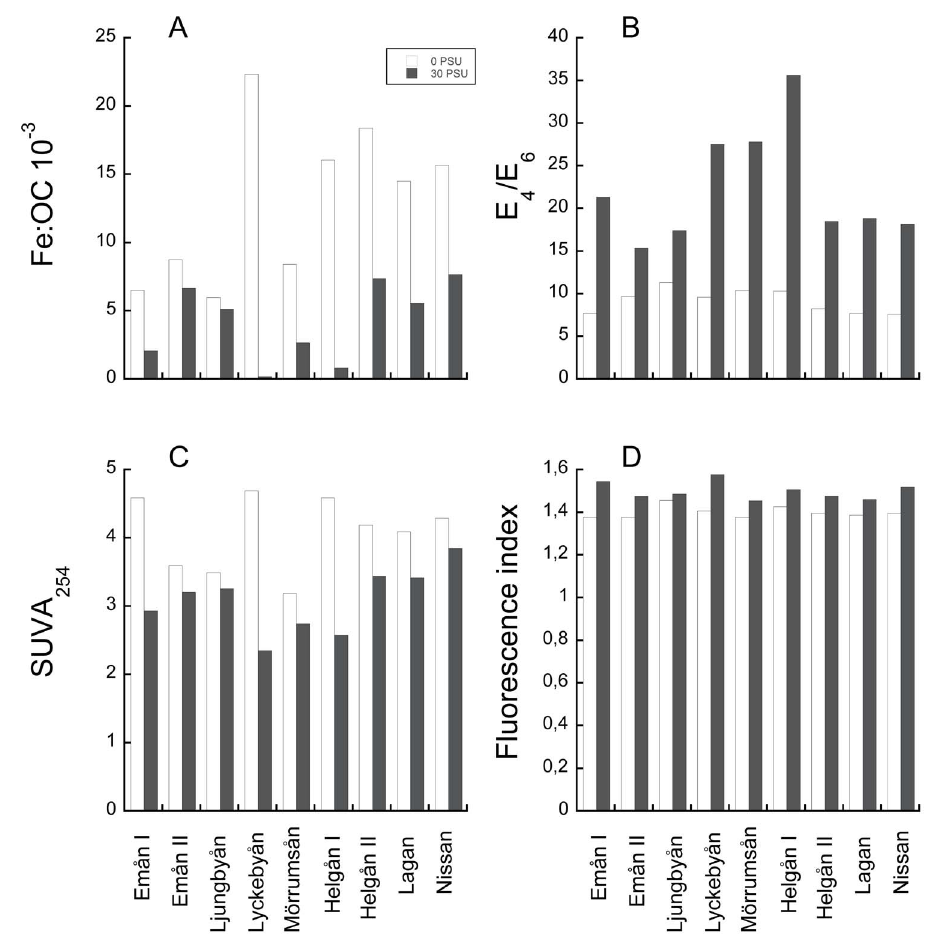
Figure 3. Differences in iron and organic matter in suspension in river waters at 0 and 30 salinity. A) ratio between iron and organic carbon, B) ratio of absorbance at 465 and 665 nm, C) specific UV absorbance at 254 nm and D) fluorescence index (ratio of emission at 470 and 520 nm and an excitation of 370 nm). doi:10.1371/journal.pone.0107500.g003 PLOS ONE |